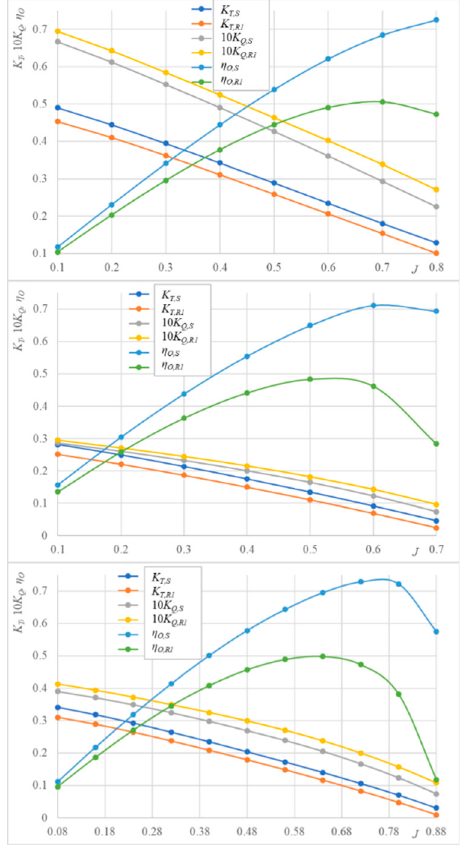
Table 13. The obtained changes in